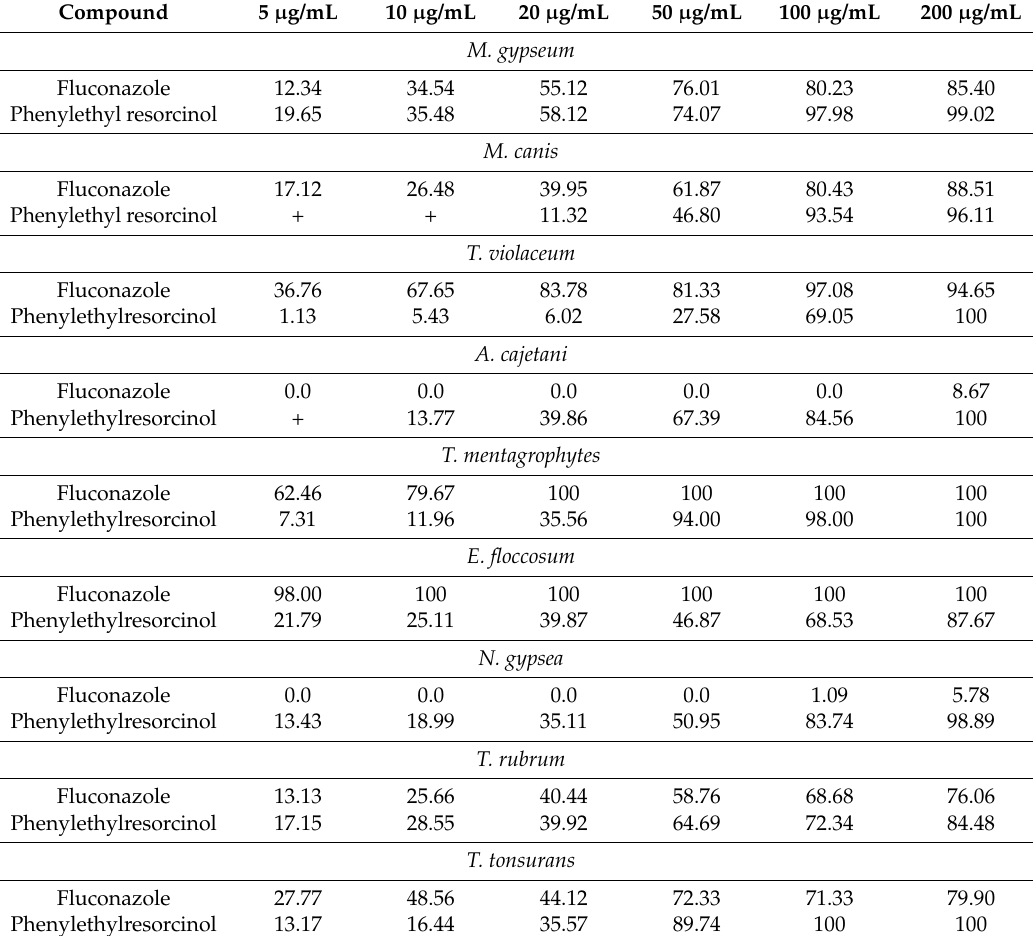
Table 2. Percent growth inhibition induced by phenylethylresorcinol on nine dermatophytes after seven days of treatment at 5, 10, 20, 50, 100 and 200 µ g/mL. The percent growth inhibition induced by fluconazole is shown for comparison purposes. Each value is the mean of three measurements (all standard deviation values, which are not reported, were within 10%).